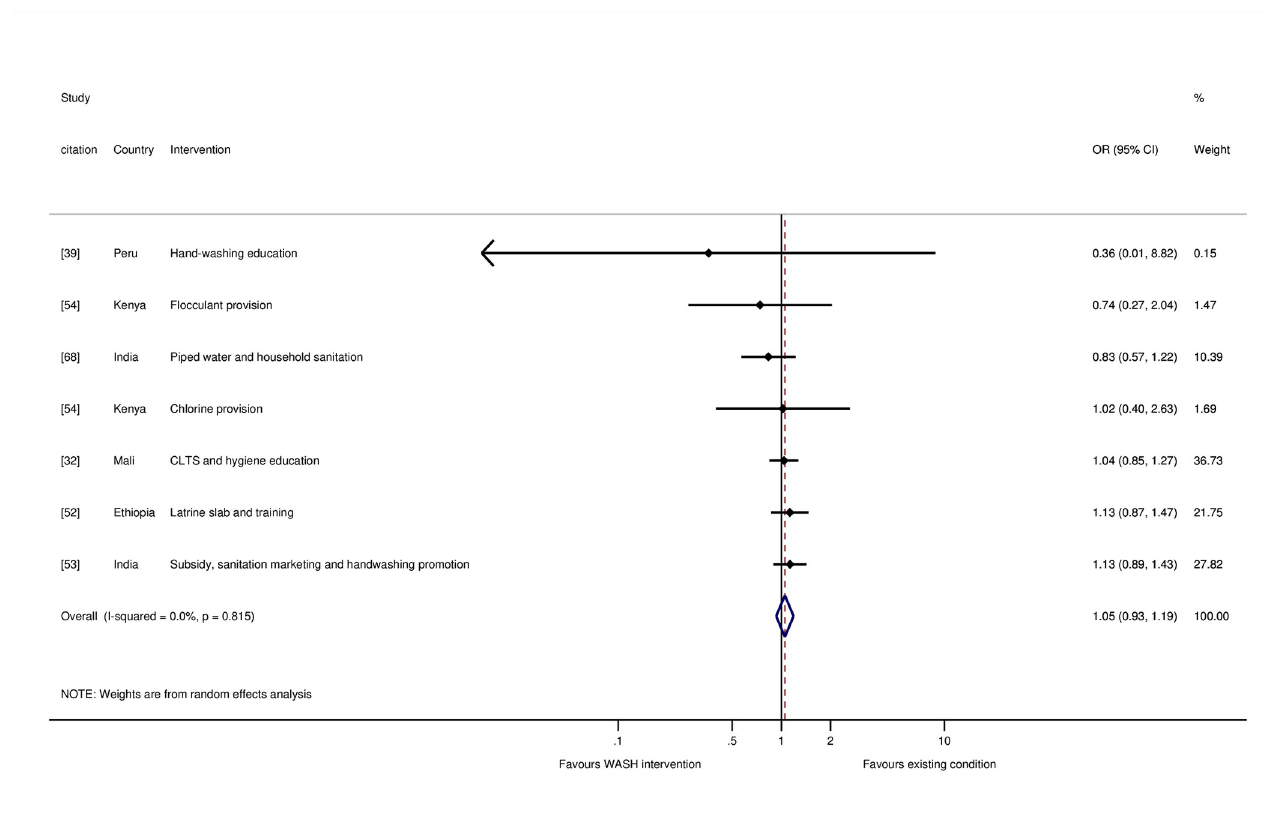
Fig 12. Effects on all-cause mortality for study participants aged over 5